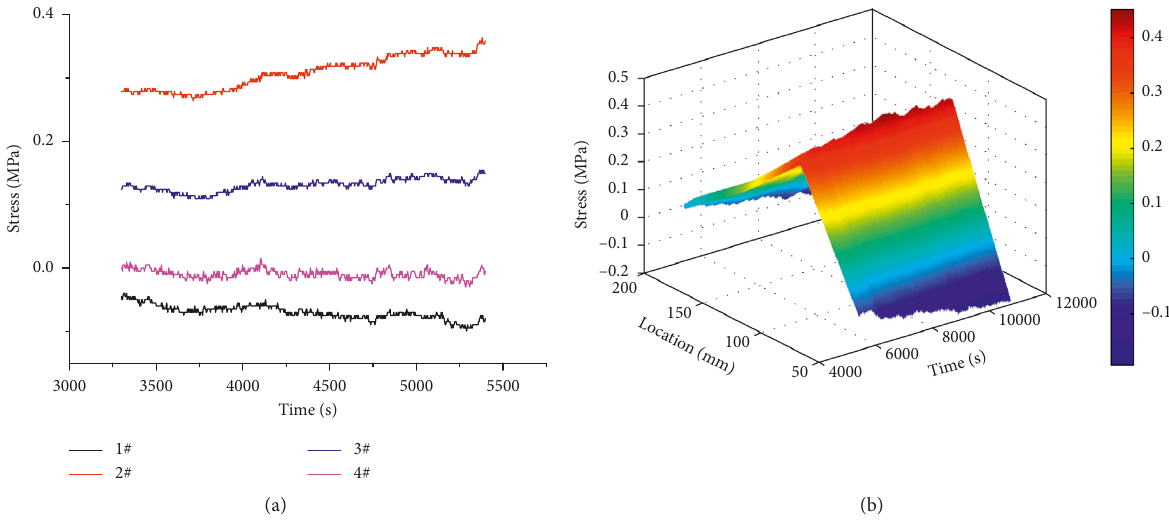
Figure 6: Stress evolution in the waiting time of the second stage: (a) stress-time curve of 4 measuring points; (b) diagram of stress distribution at different locations over time.